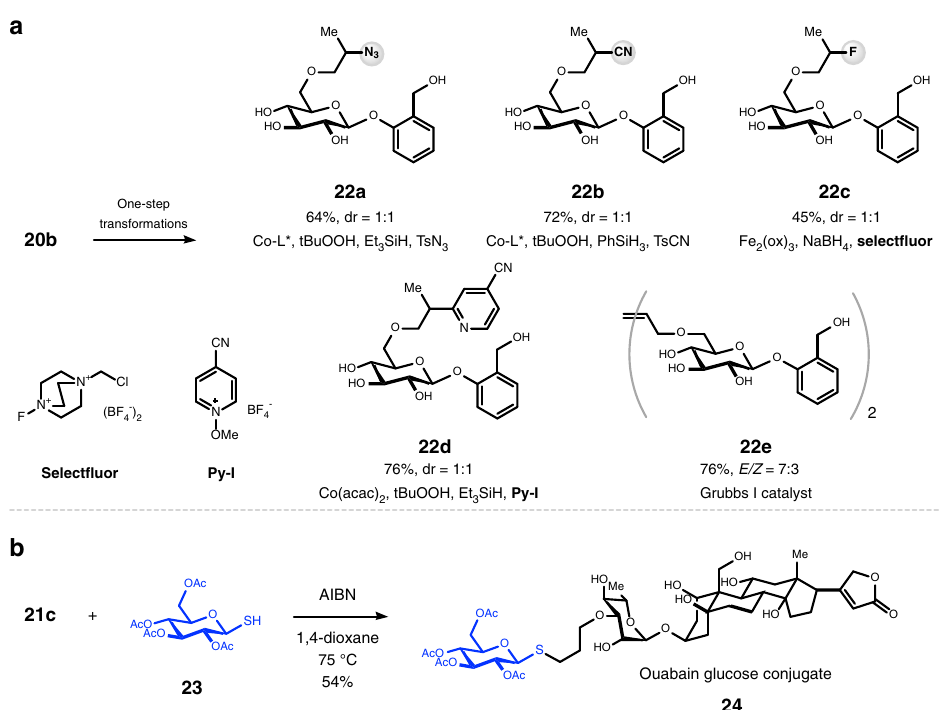
Fig. 6 Product derivatization. a Derivatization of 20b . b Derivatization of 21c . Product ratios were determined by 1 H NMR analysis of crude reaction mixtures. See Supplementary Information for experimental details. L* = ( R,R )-( − )- N , N ’ -Bis(3,5-di- tert -butylsalicylidene)-1,2-cyclohexanediamine. ox